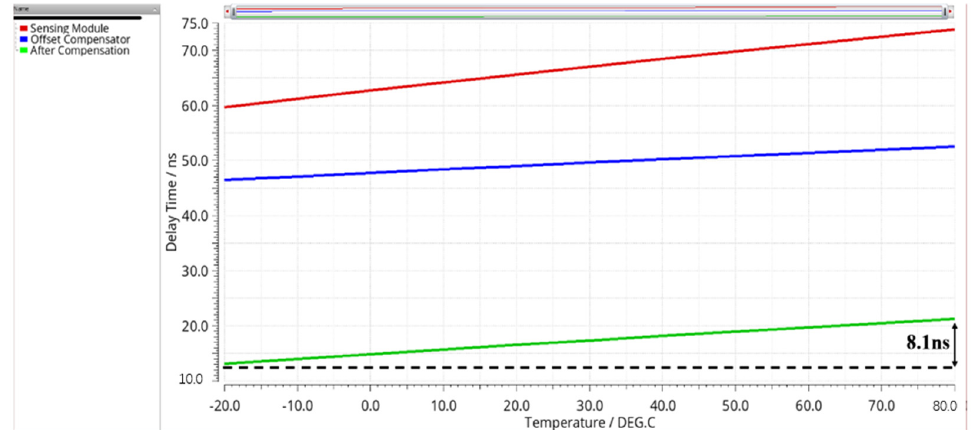
Figure 5. Simulated delay time of the sensing module and the offset compensator over the tempera- ture range of –20~80 ◦ C.